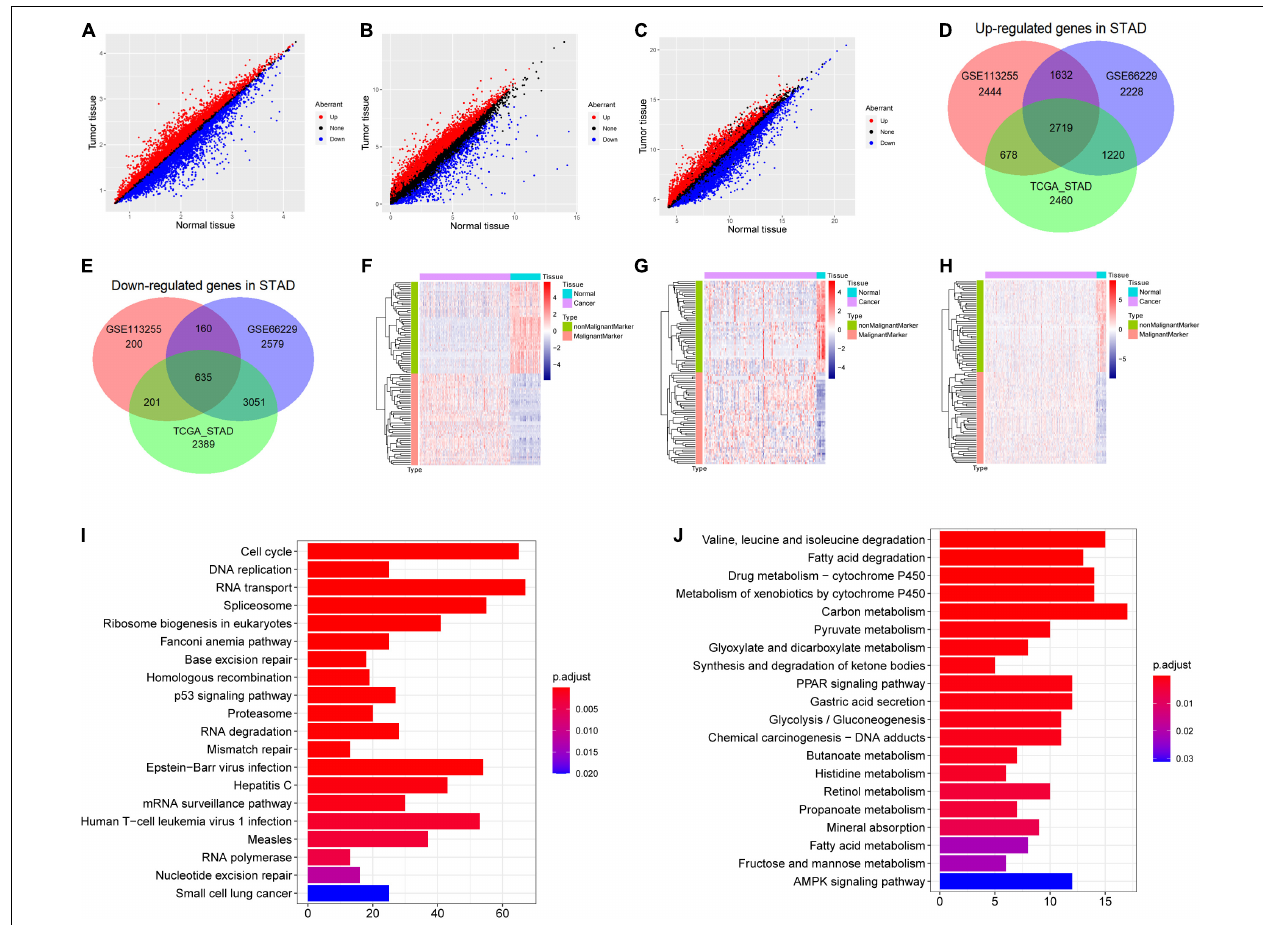
FIGURE 2 | Screening differentially expressed genes (DEGs) in stomach adenocarcinoma (STAD) and malignant and non-malignant cell markers. (A) DEGs in GSE66229; (B) DEGs in GSE113255; (C) DEGs in The Cancer Genome Atlas (TCGA)-STAD dataset. (D) Venn plot of overlap up-regulated genes in the three dataset. (E) Venn plot of overlap down-regulated genes in the three dataset. (F) Expression heat map of malignant and non-malignant cell markers in GSE66229. (G) Expression heat map of malignant and non-malignant cell markers in GSE113255. (H) Expression heat map of malignant and non-malignant cell markers in TCGA-STAD dataset. (I) The top 20 significant Kyoto Encyclopedia of Genes and Genomes (KEGG) pathways (ranked by p value) involving the overlapping up-regulated genes. (J) The top 20 significantly KEGG pathways (ranked by p value) involving the overlapping down-regulated